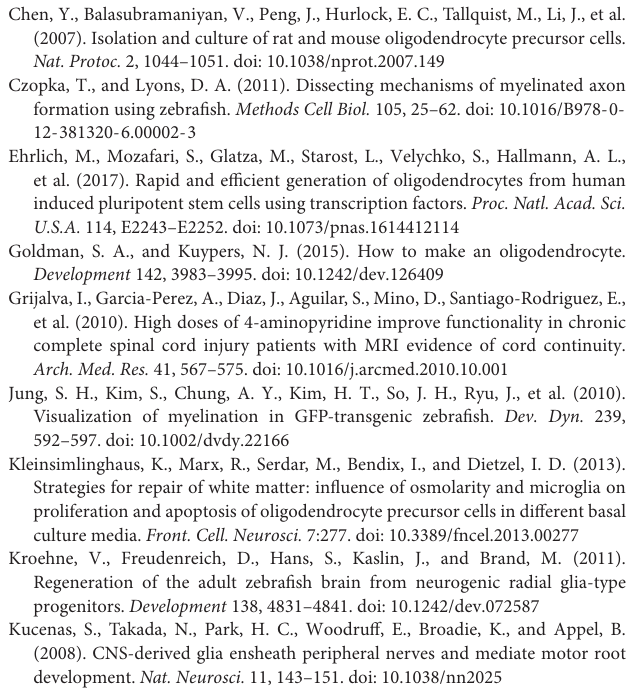
FIGURE S1 | Overlap of olig2 :GFP expression and nuclear Sox10 antibody staining in the adult zebrafish spinal cord. Almost all olig2 :GFP-expressing cells in the parenchyma show a nuclear signal for Sox10 (arrowheads). Also GFP-negative longitudinal structures in the parenchyma and along the midline dorsal to the central canal (asterisk) show a signal for Sox10. These structures could represent axonal processes (from sensory neurons: dorsal root and sympathetic ganglia) and meninges-like membranes. 50 µ m cross section; scale bar represents 100 µ m. FIGURE S2 | Strategy to sort OLs using FACS. Gating of OLs based on mbp :GFP and nuclear counter stain signals. FIGURE S3 | Morphology of OPCs varies with different numbers of MNs. Without the addition of MNs, most OPCs have a small and round morphology at 1 DIC. The number and branching complexity of OPC processes increase when MNs are added and are highest at the highest MN density of 160000 cells; scale bar represents 50 µ m. FIGURE S4 | After longer culture periods OPCs adopt the morphology of mature OLs in OPC/MN co-cultures. At 7 DIC OPC processes increase in size, length and complexity of branching compared to 2 DIC. At 7 DIC the proximal region of the processes is enlarged compared to more distal regions (arrowhead). In the central part of some processes close association of axon and oligodendroglial processes can be seen (arrowheads); scale bar represents 50 µ